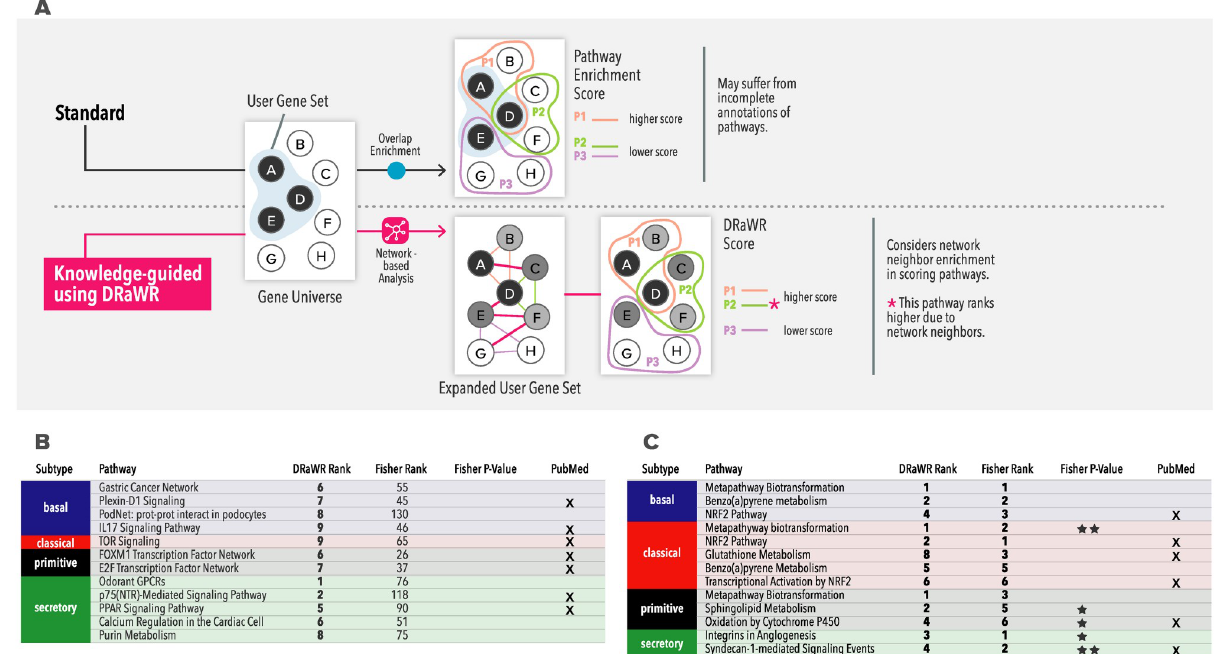
Fig 6. Knowledge-Guided GSC. (A) Common approaches to GSC examine the overlap (top) between a user-provided gene set (e.g., genes A, D, E) and genes in a pathway (e.g., A, D, B in pathway P1). In the (bottom) knowledge network-guided mode (algorithm DRaWR), the association between 2 gene sets is based not only on direct overlap between them but also on network-based proximity between them. (B) LUSC subtype-associated pathways found exclusively with network-guided GSC pipeline using DRaWR. (C) Pathways associated with LUSC subtypes found by standard as well as network-guided GSC pipelines. GSC, gene set characterization; LUSC, lung squamous cell carcinoma.